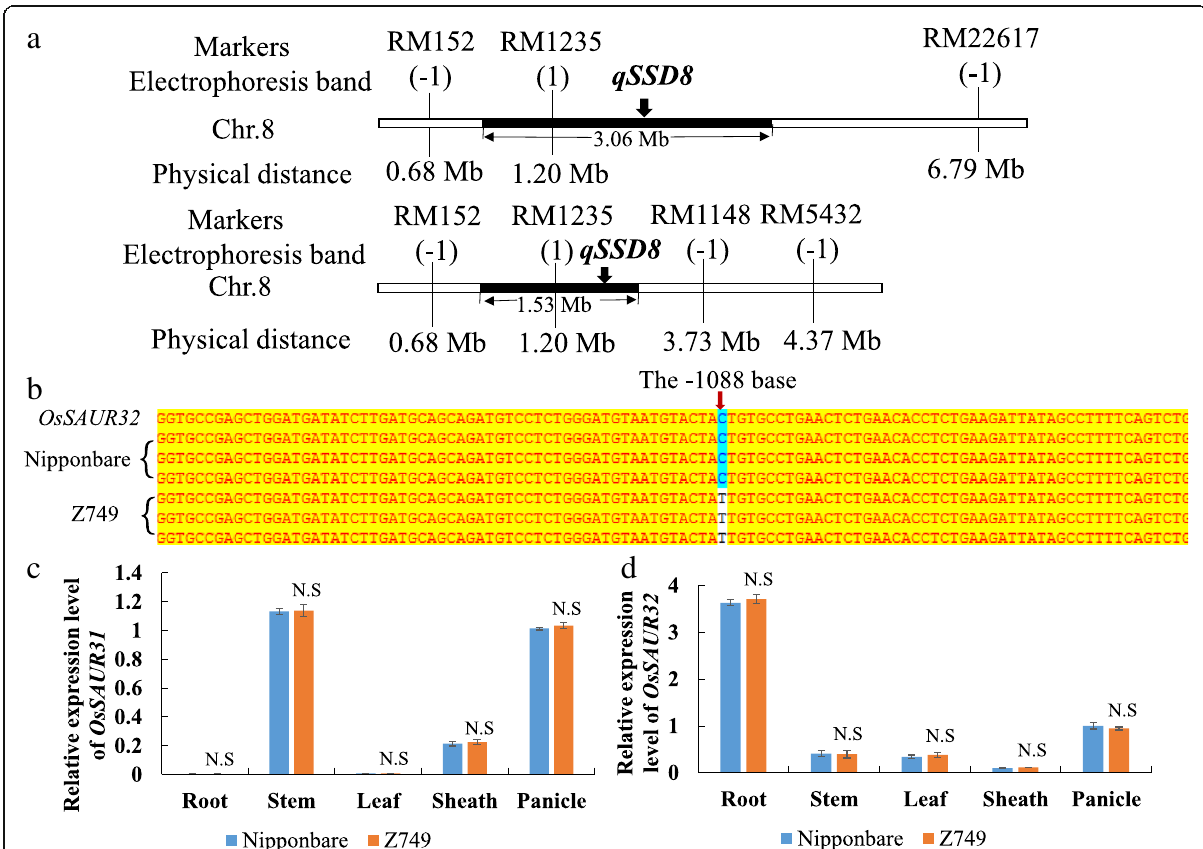
Fig. 7 Fine mapping of qSSD8 and analysis of DNA sequence and expression levels of its candidate genes. a Fining mapping of qSSD8 . b Nucleotide sequence of OsSAUR32 ( LOC_Os08g02530 ) in Z749 compared with that of Nipponbare. − 1 indicates that the band for S4 was identical to that of Nipponbare; 1 indicates that the band for S4 was identical with Xihui18. c , d The relative expression levels of OsSAUR31 and OsSAUR32 in root, stem, leaf, sheath and panicle between Nipponbare and Z749, respectively